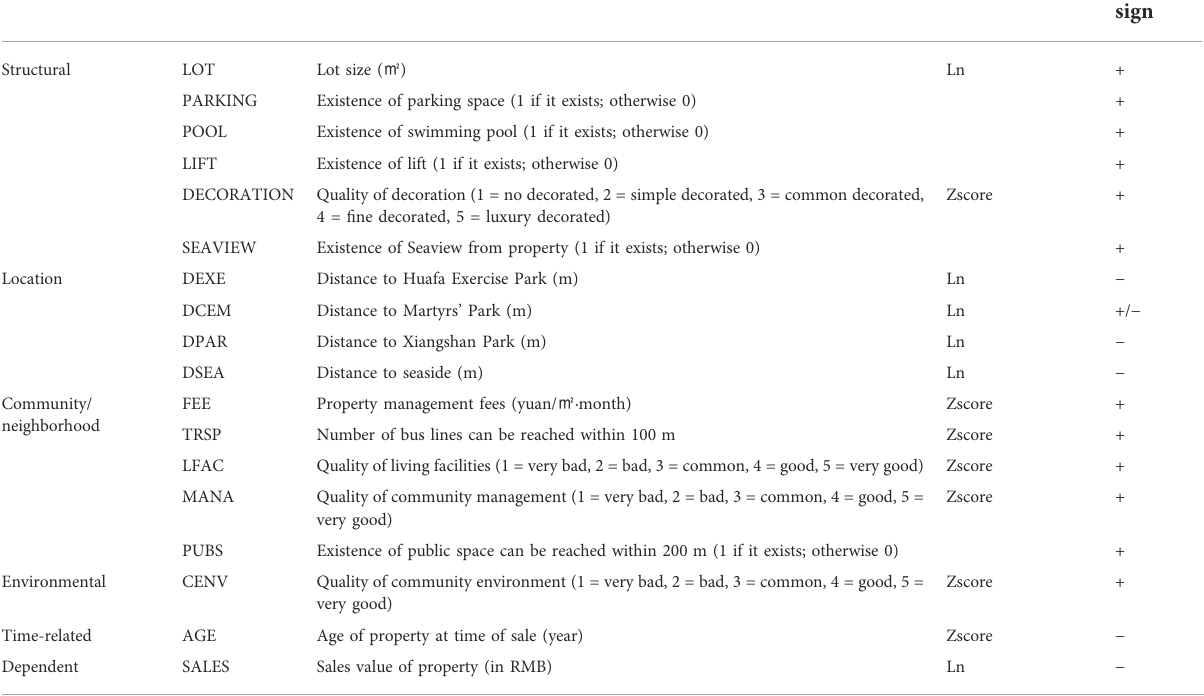
TABLE 1 Summary and de fi nition for variables.